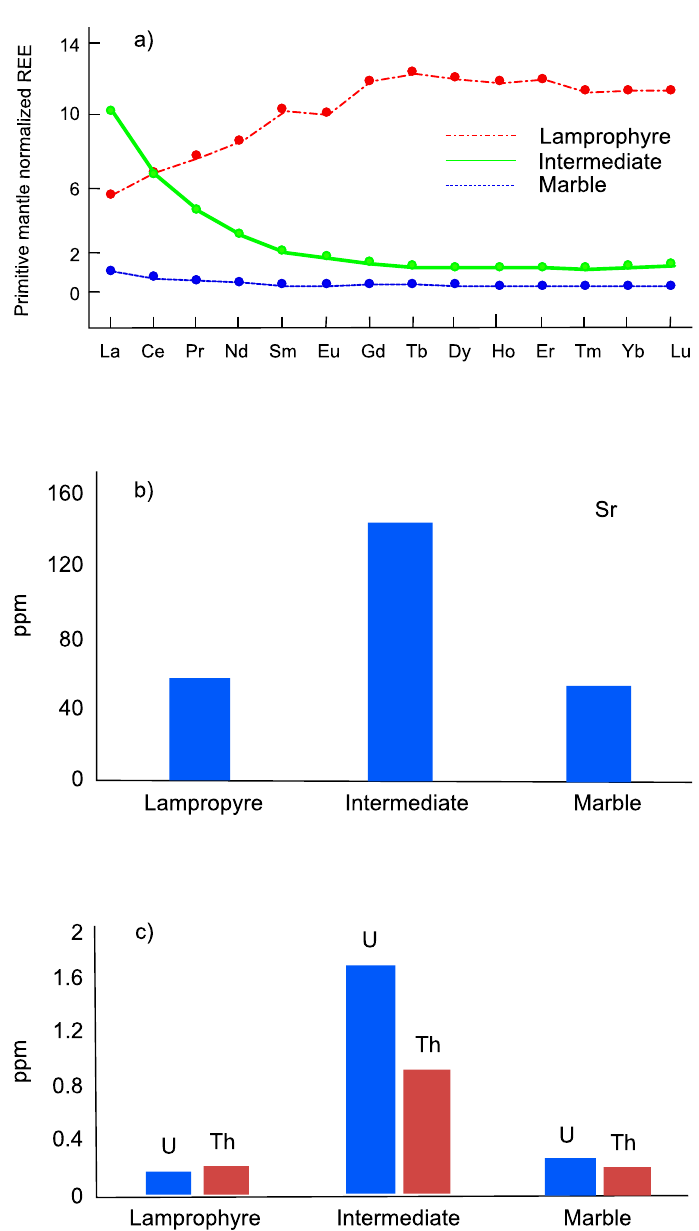
Figure 8. Geochemical enrichment of trace elements during metasomatism. ( a ), Primitive mantle normalized REE diagram ( b ), Sr variation ( c ), U and Th variation from the representative samples.